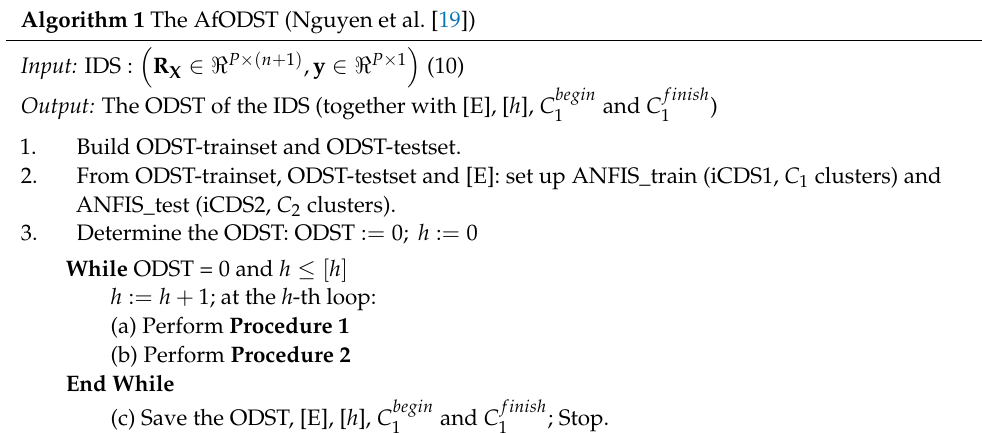
Algorithm 1 The AfODST (Nguyen et al.